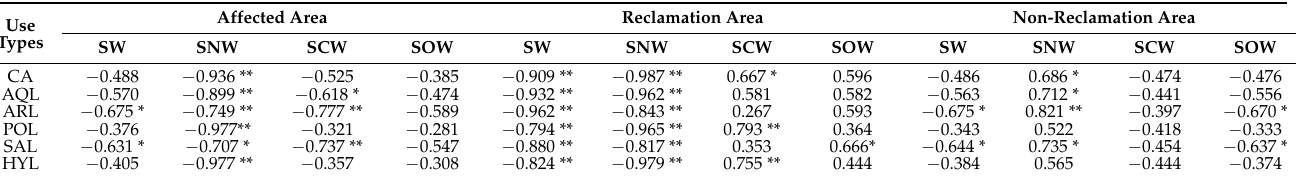
Table 4. Correlation matrix between stability index and area of